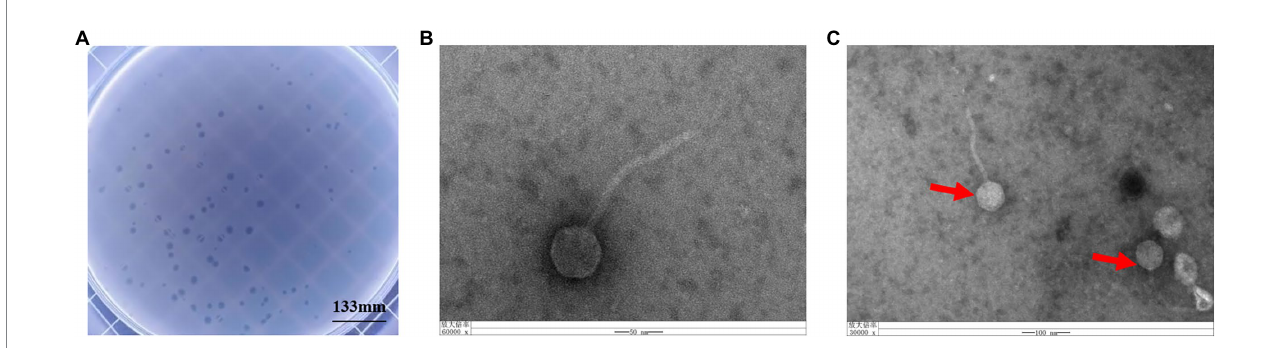
FIGURE 1 Plaque morphology of bacteriophage vB_KpnS_SXFY507. (A) Phage plaques formed of phage vB_KpnS_SXFY507 on the lawn with Klebsiella pneumoniae SXFY507. (B,C) Transmission electron microscopy of phage